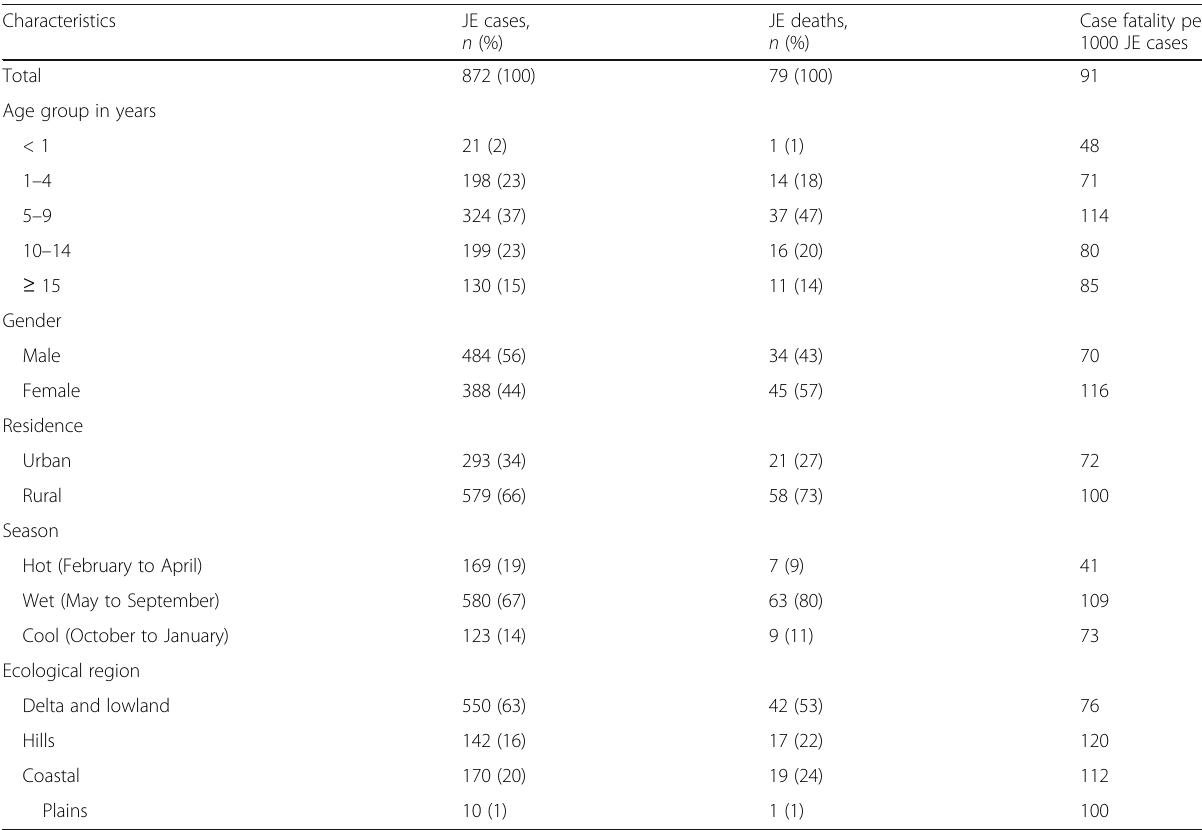
Table 3 Demographic characteristics, seasonal changes, and the ecological distribution of hospital-recorded JE cases, JE deaths, and case fatality rates in Myanmar between 2012 and 2017 Characteristics